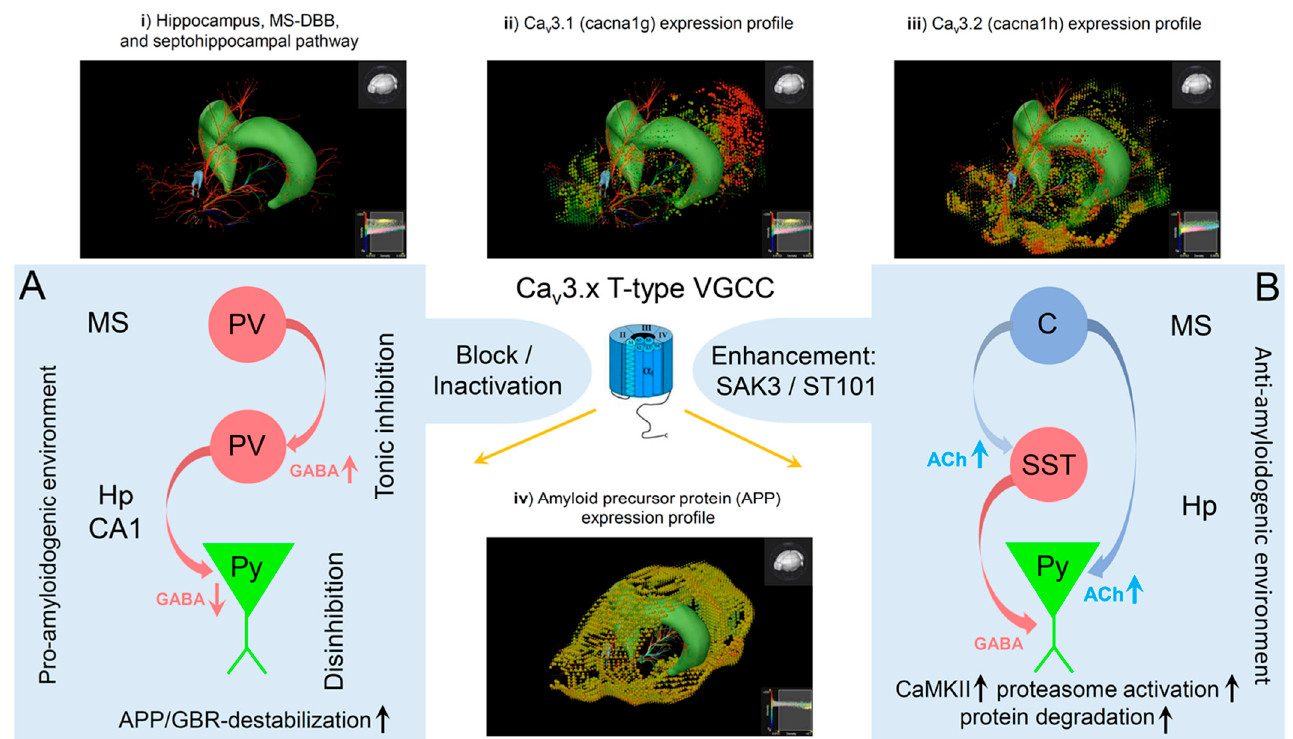
Figure 3. Ca v 3.x VGCC activation and inhibition and the potential consequences for anti- and proamyloidogenic effects. The 3D illustrations present (i) the hippocampus, the MS-DBB, and the connecting fibers; (ii) the 3D projection of Ca v 3.1 ( α 1 G) transcript data/expression; (iii) the 3D projection of Ca v 3.2 ( α 1 H) transcript data/expression; and (iv) the 3D projection of the APP transcript/expression profile. Transcript data points are displayed in sagittal sections for the left brain. Three-dimensional (3D) illustrations and integration of transcript data were done using Allen Brain Mouse Atlas - Brain Explorer ® 2 [286]. Note that no 3D representation of Ca v 3.3 ( α 1 I) expression is presented, as transcript data were not available using Brain Explorer ® 2. ( A ) Ca v 3.x VGCCs can be blocked by various antagonists with different specificities. As outlined in our proposed model, inhibition of T-type VGCCs can favor tonic firing in parvalbumin (PV)-positive interneurons in the medial septum (MS). Subsequently, increased GABAergic projection on PV-positive hippocampal GABAergic interneurons results in functional disinhibition of hippocampal pyramidal neurons (Py). A reduction in GBR expression and/or cell surface expression could lead to destabilization of the APP/GBR complex as described previously. In total, inhibition of Ca v 3.x T-type VGCCs might constitute a proamyloidogenic environment. ( B ) Activation of T-type VGCCs, e.g., via ST101 or SAK3, was shown to enhance ACh release from septal cholinergic neurons. The latter can project on somatostatin (SST)-positive GABAergic interneurons or pyramidal neurons (Py) in the hippocampus. It has been suggested that Ca v 3.x mediated enhancement of ACh release might trigger CaMKII- and proteasome activation with subsequent enhancement of protein degradation. Thus, activation of T-type Ca 2+ channels might generate an antiamyloidogenic environment. In summary, inhibition of Ca v 3.x is suggested to trigger A β synthesis and plaque formation via destabilization of APP/GBRs assemblies and reduced CaMKII/proteasome activation. In contrast, stimulation of Ca v 3.x is likely to stabilize APP/GBR microcomplexes and to enhance CaMKII/proteasome-mediated A β /plaque